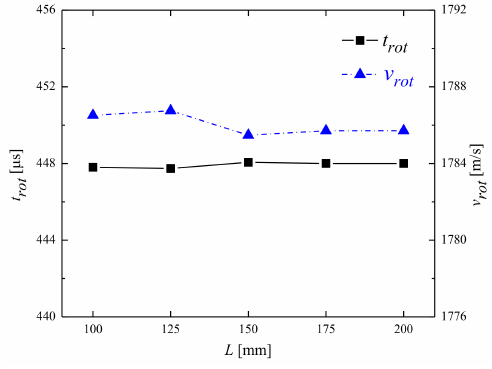
Figure 14. Variations in t rot and v rot with different axial